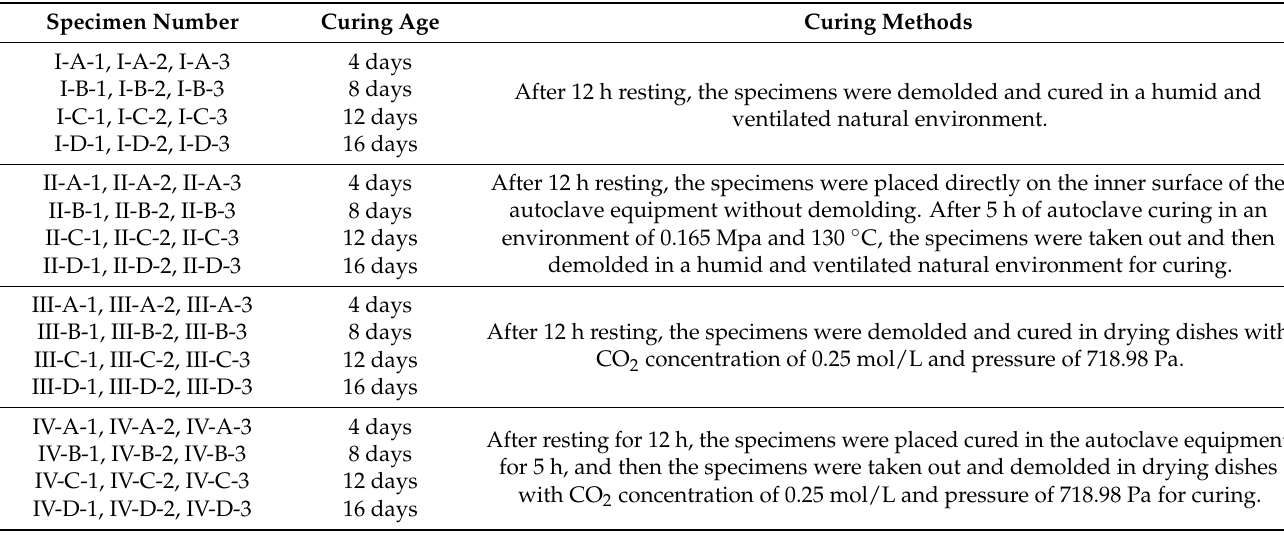
Table 1. Specimens’ curing method.